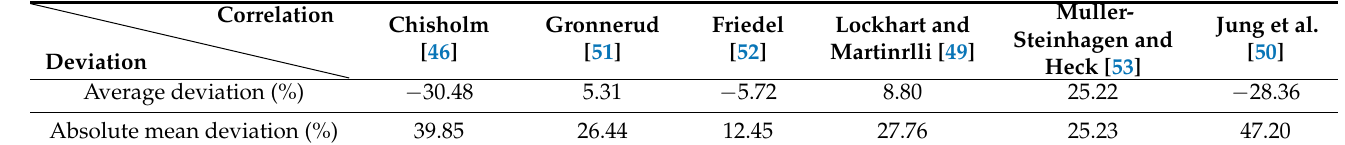
Table 12. Comparison of deviation between the calculated and experimental pressure drops for all data.